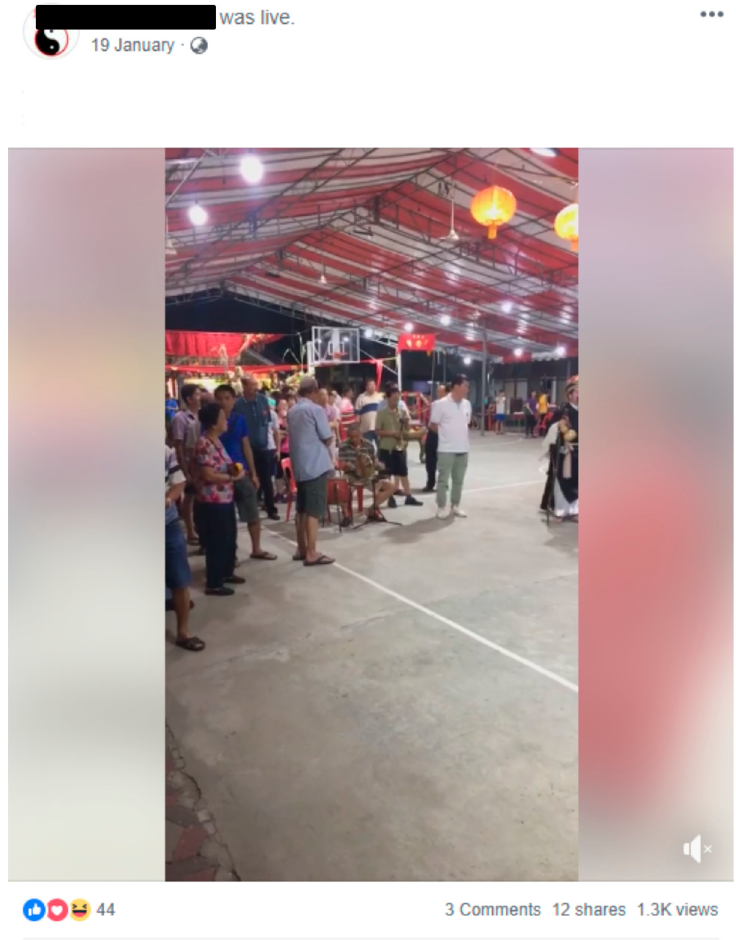
Figure 6. Facebook Live Streaming of the Celebration of a Deity’s Birthday. This Facebook Live Stream was started by one of the temple assistants during the celebration of the deity’s birthday. The name of the sintua has been redacted to protect its anonymity.